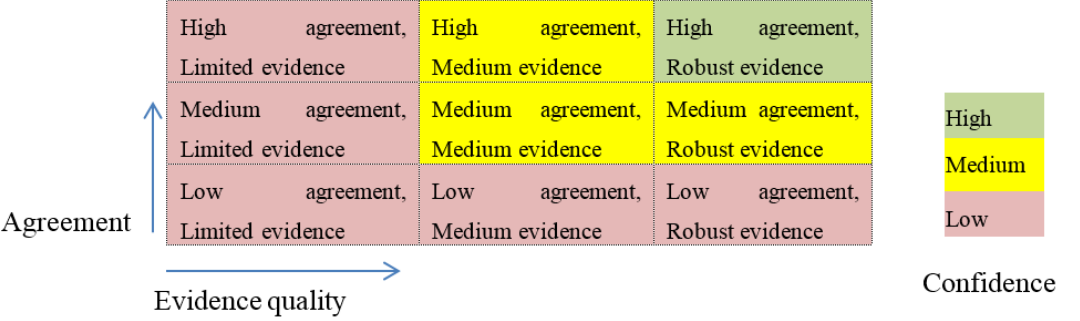
Figure 2. Framework used for uncertainty assessment (adapted from IPCC